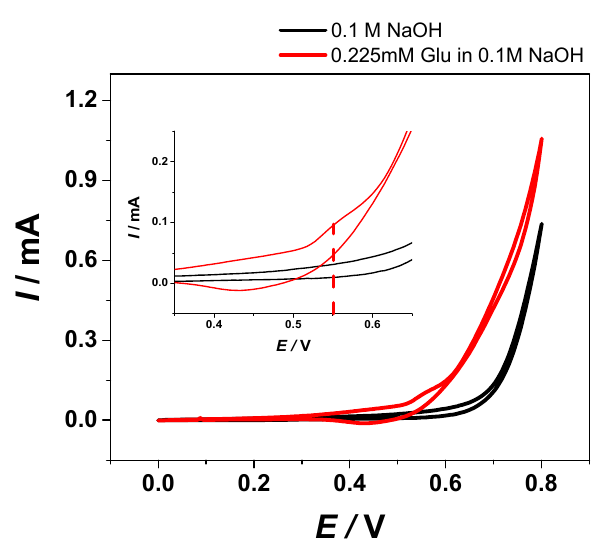
Figure 6. CV of the Cu / Ni f working electrode in the absence (black line) and in the presence of 0.225 mM Glu (red line) in 0.1 M NaOH aqueous solution (scan rate: 10 mV / s, working electrode surface area of 25 mm 2 ).